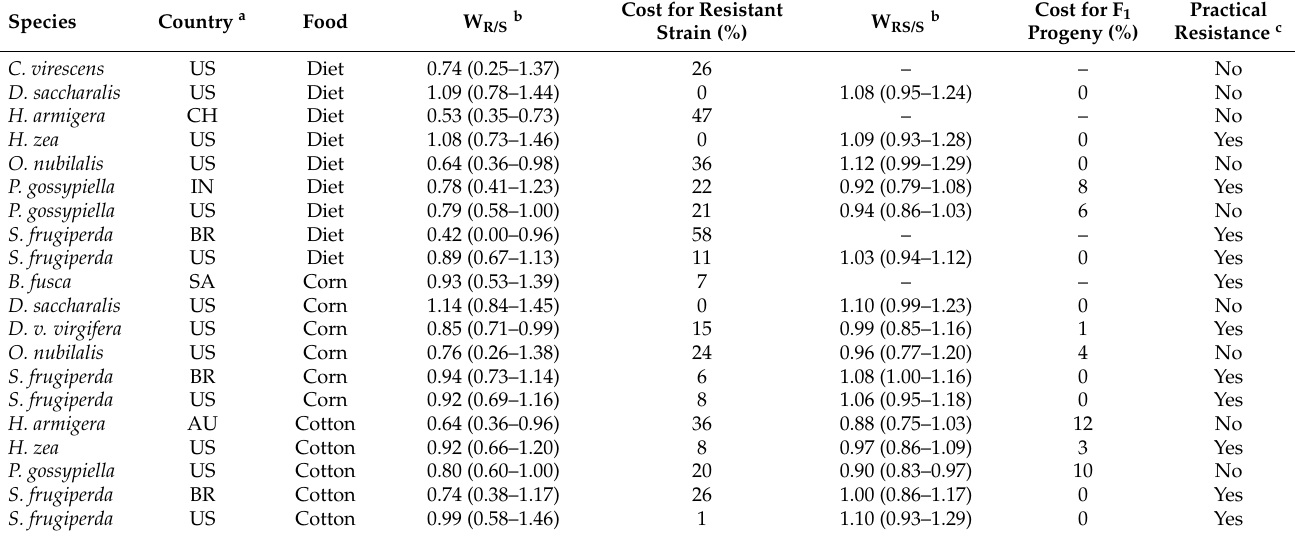
Table 1. Fitness ratios (W R/S and W RS/S ) and associated fitness costs of